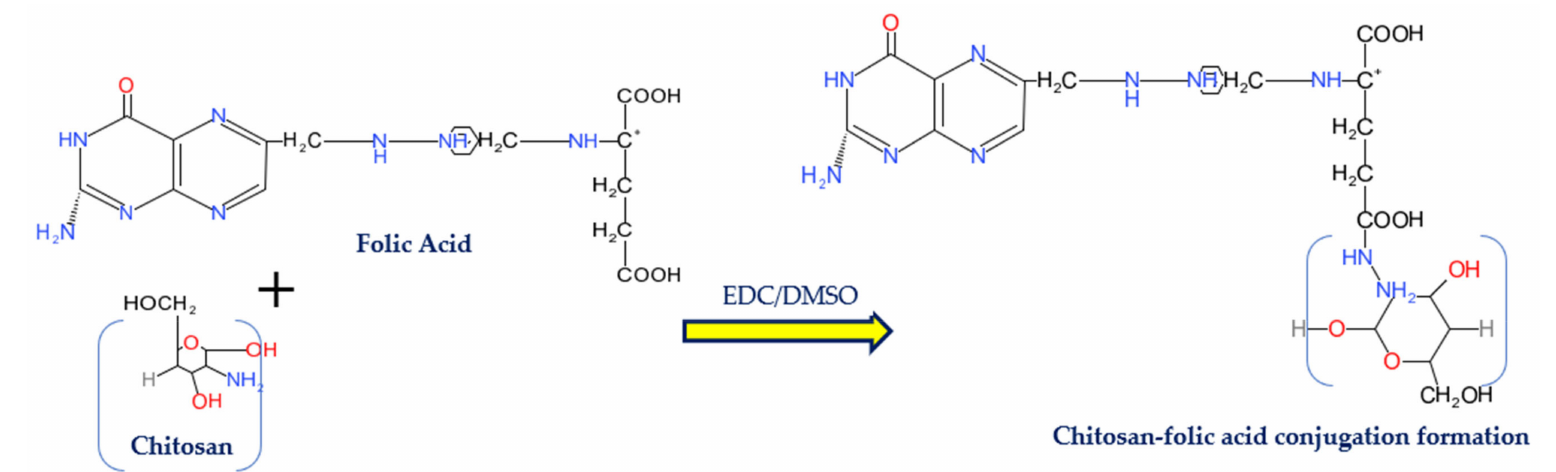
Figure 1. A scheme illustrating the reaction of chitosan with folic